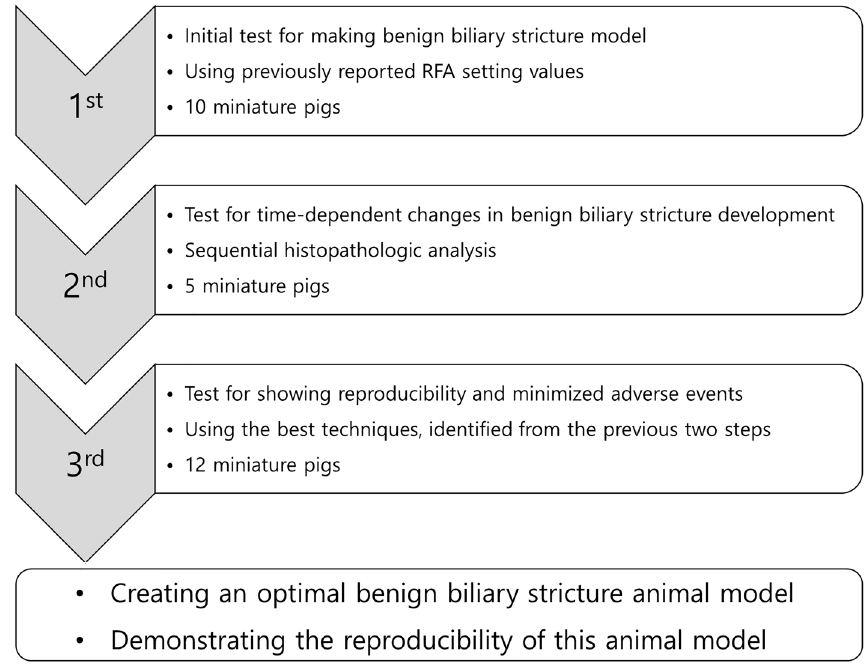
Figure 3. Schematic diagram of the experimental steps for the study